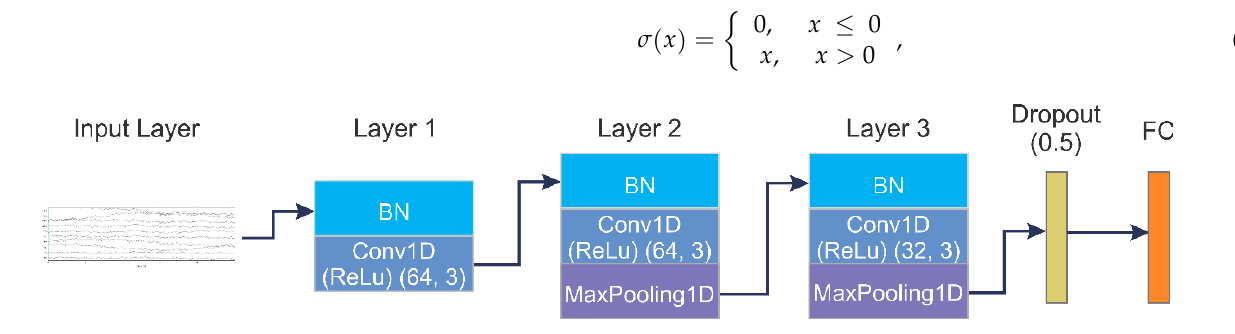
Figure 3. 1D-CNN model for EEG data.